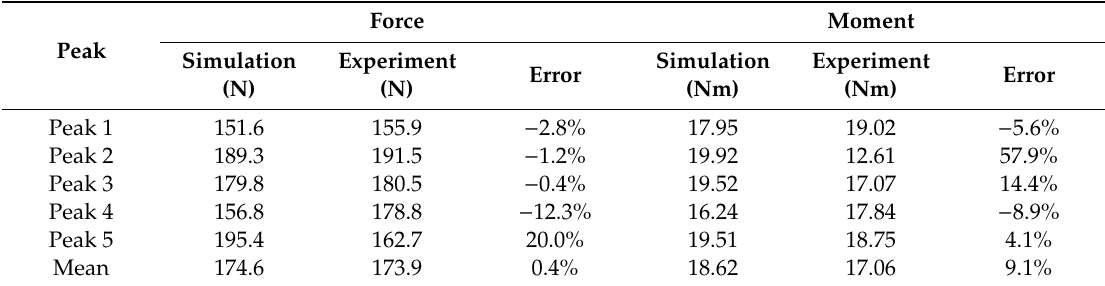
Table 3. Comparison of peak ice force and moment.